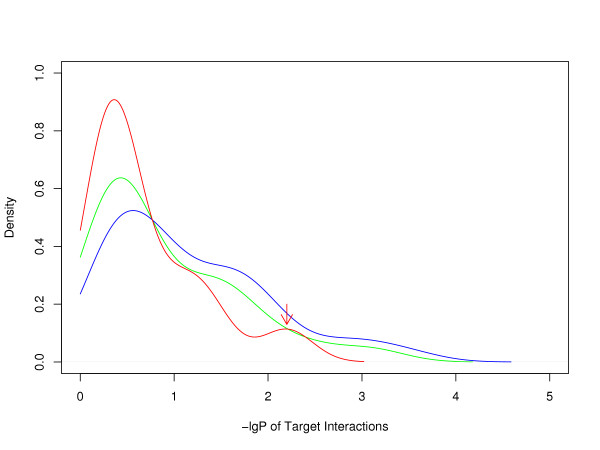
Coordination among non-conserved sc-miRNAs (red curve) is weaker than that among conserved sc-miRNAs (blue curve). -lgP of Target interactions between conserved and non-conserved sc-miRNAs is shown in green curve. The arrow-pointed peak in non-conserved miRNAs was formed due to coordination within rapidly evolving non-conserved families in mir-379 cluster.